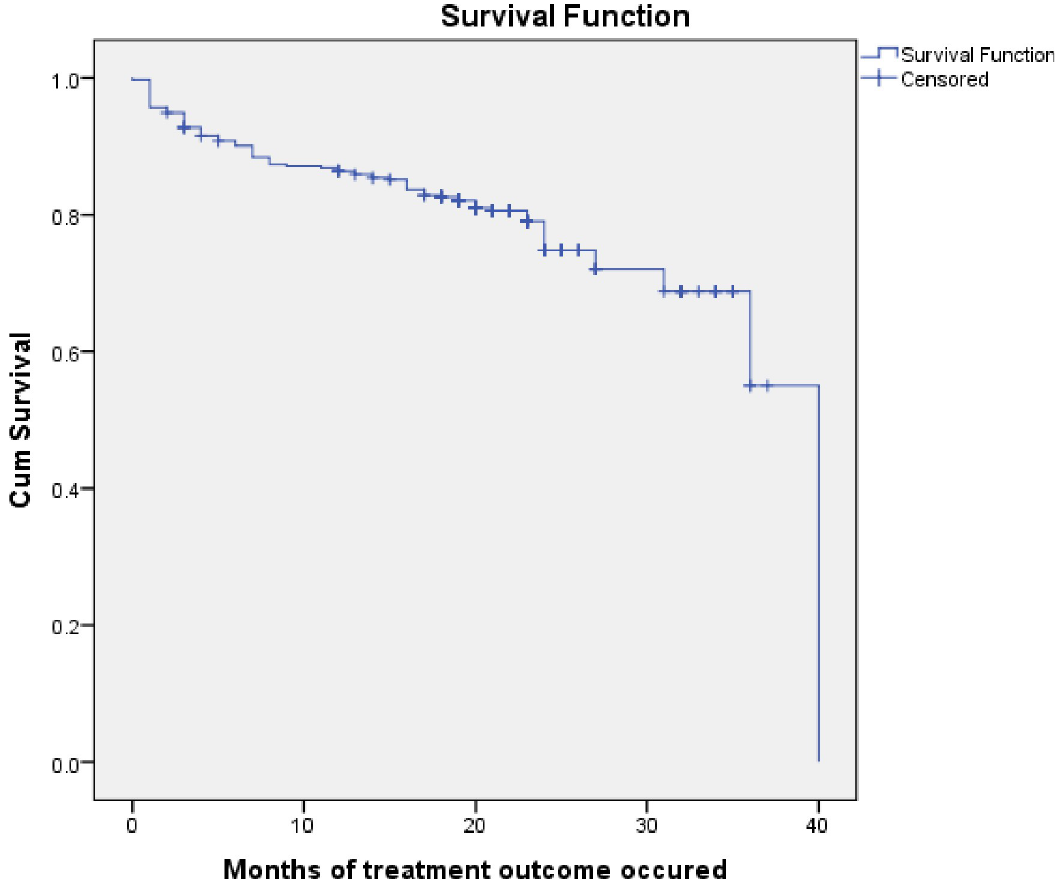
Fig 2. Kaplan–Meier curve showing the probability survival of MDR-TB patients since the commencement of treatment to end of the treatment follow up at Oromia hospitals, Oromia, Ethiopia.